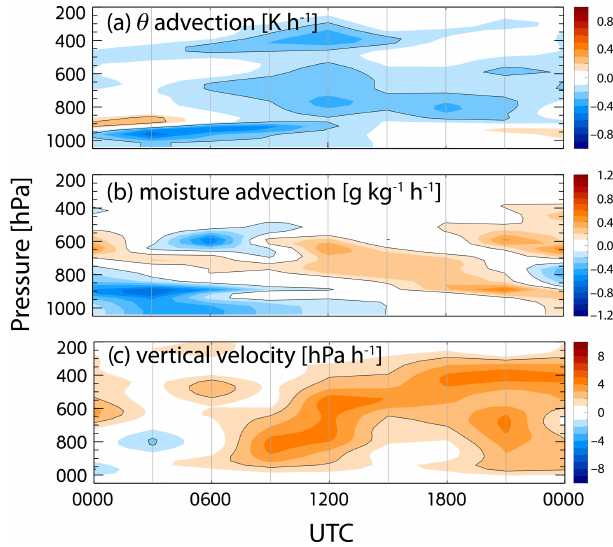
Figure 3. Time–height sections of potential temperature and mois- ture advection, and large-scale vertical velocity taken from the ARM VARANAL product. The simulation period is from 06:00 to